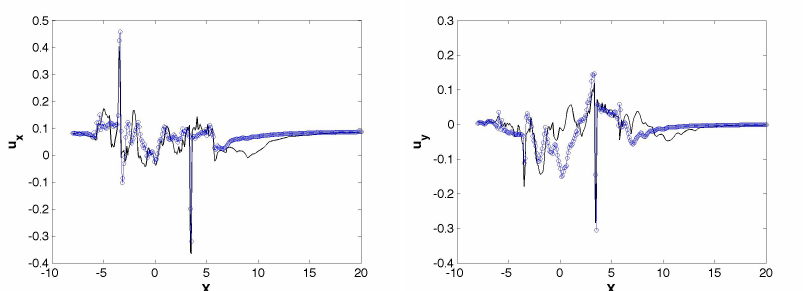
Figure 17. Counterpart of Figure 7 in the three-blades turbine applying HODMD in 145 snapshots starting at time 25.604 s. Data extracted at y = 2